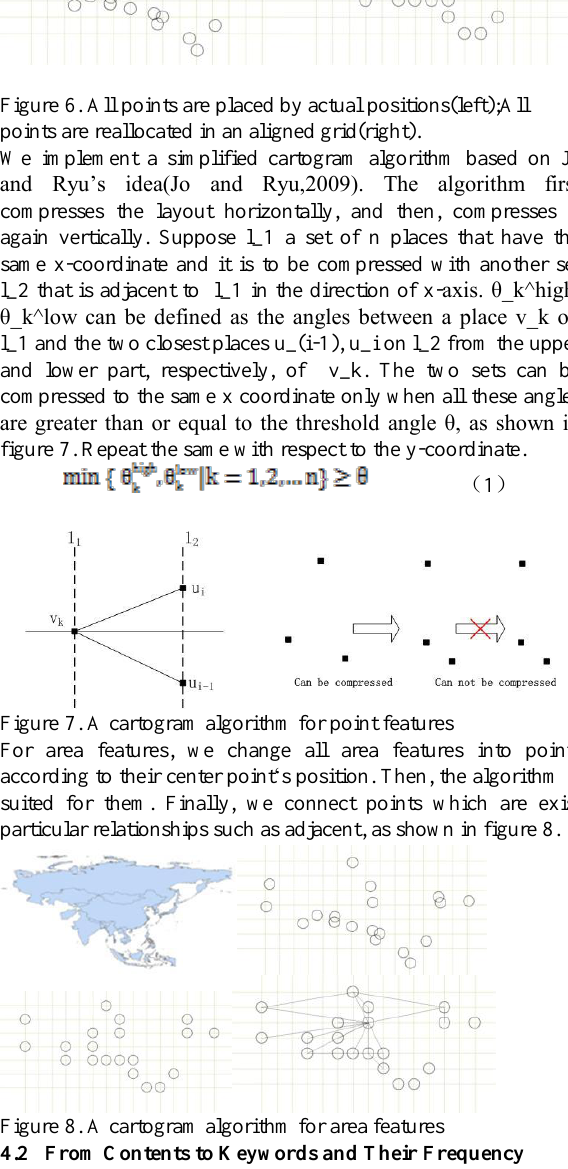
Figure 11. Providing various models to represent the same